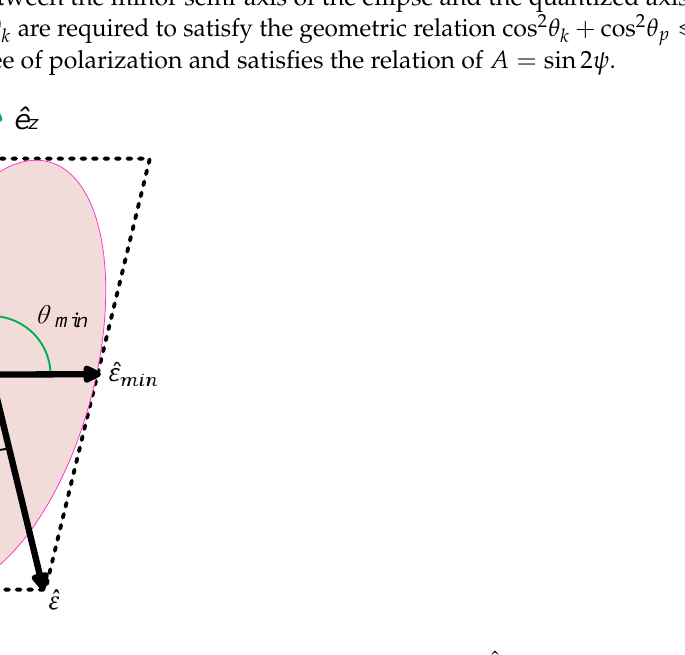
Figure 1. The geometrical parameters of electromagnetic plane waves. ˆ k , ˆ e z , and ˆ ε are the unit wave vector, the quantized axis, and the laser polarization vector, respectively. The parameters θ maj , θ min , and θ k are the angles between each unit vector and the quantized